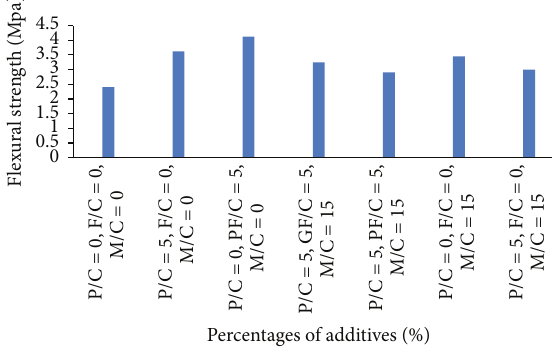
Figure 14: Flexural strength at age of 28